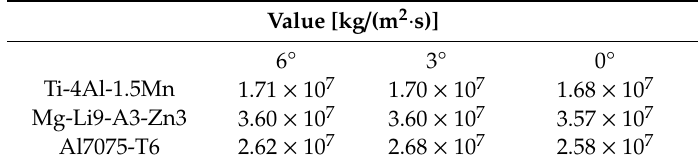
Table 7. Average erosion rates of the three material at di ff erent angles of attack.